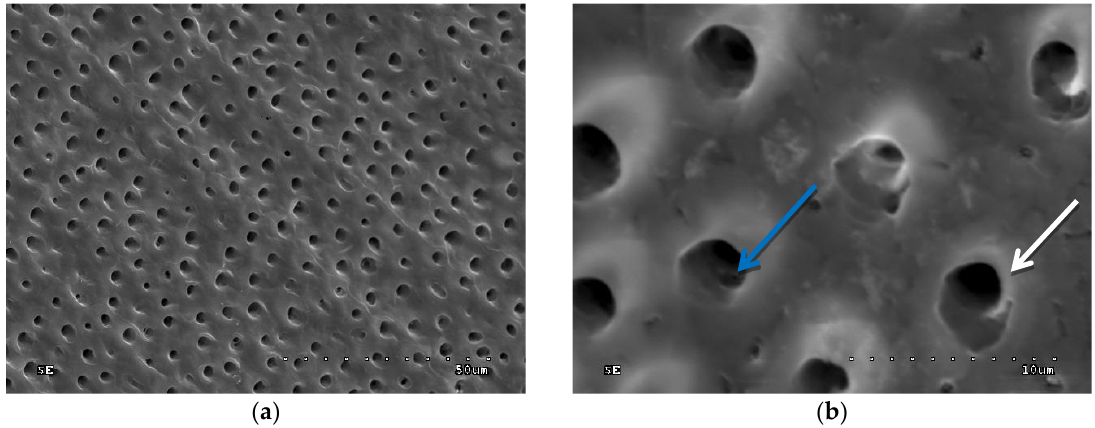
Figure 7. SEM image of dentine surface after application of 0.2% CHG for 15 s and acid etching—group 8: ( a ) 1000×; ( b ) 5000×. Blue arrow indicates open lateral dentinal tubule. White arrow—peritubular dentine residues.